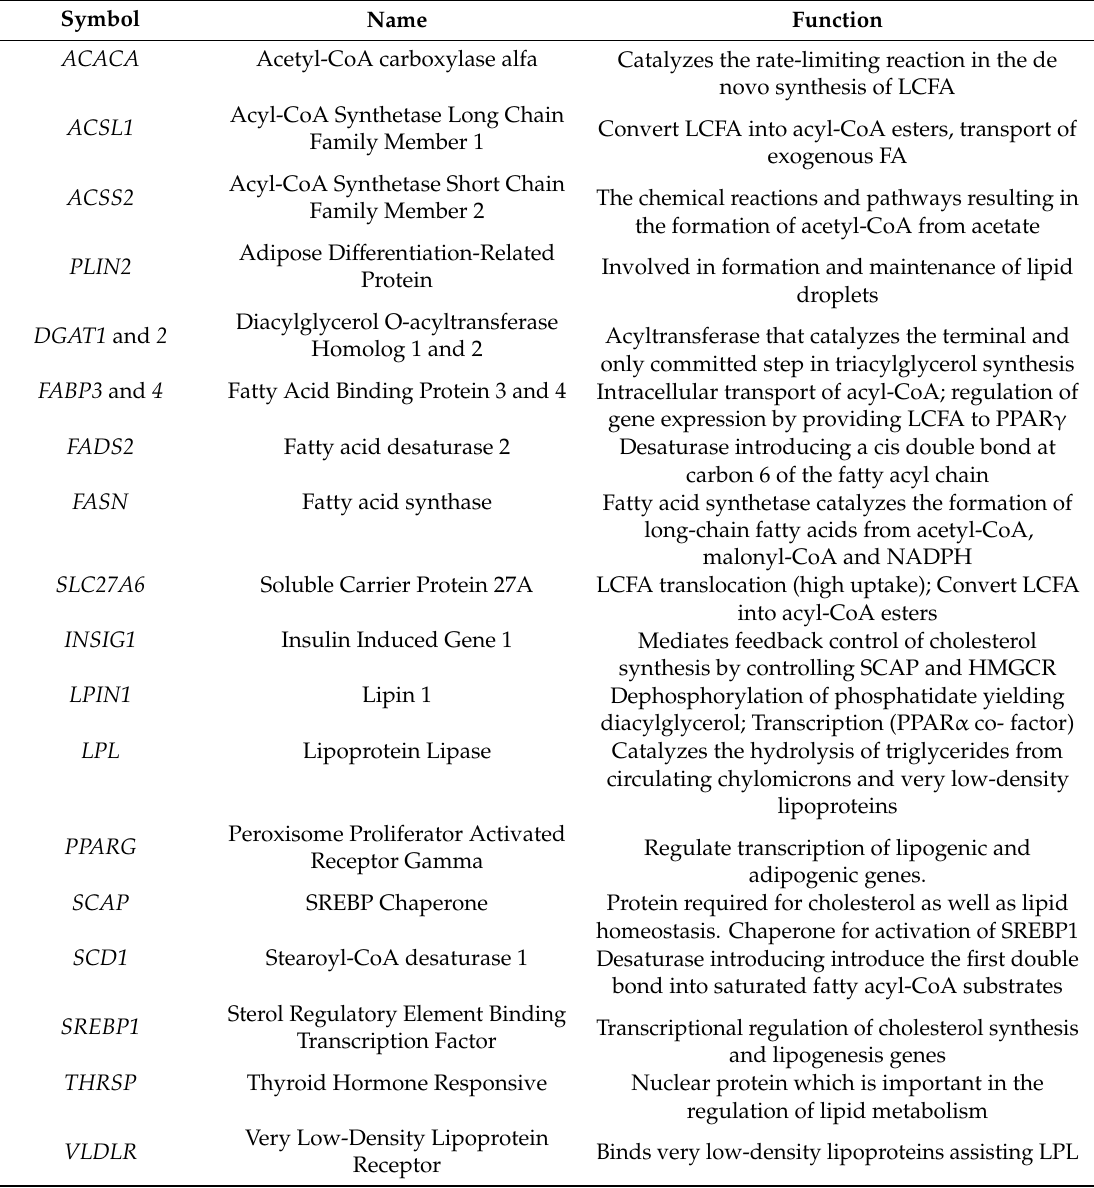
Table 2. Gene symbol, name, and lipogenesis-related functions of the 20 genes evaluated in the present